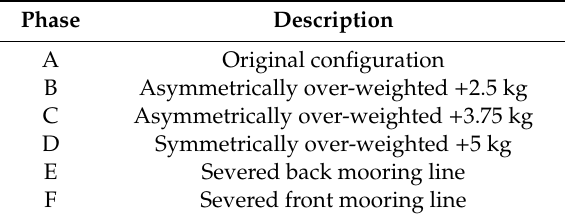
Table 2. Structural configurations for different test phases representing damage.